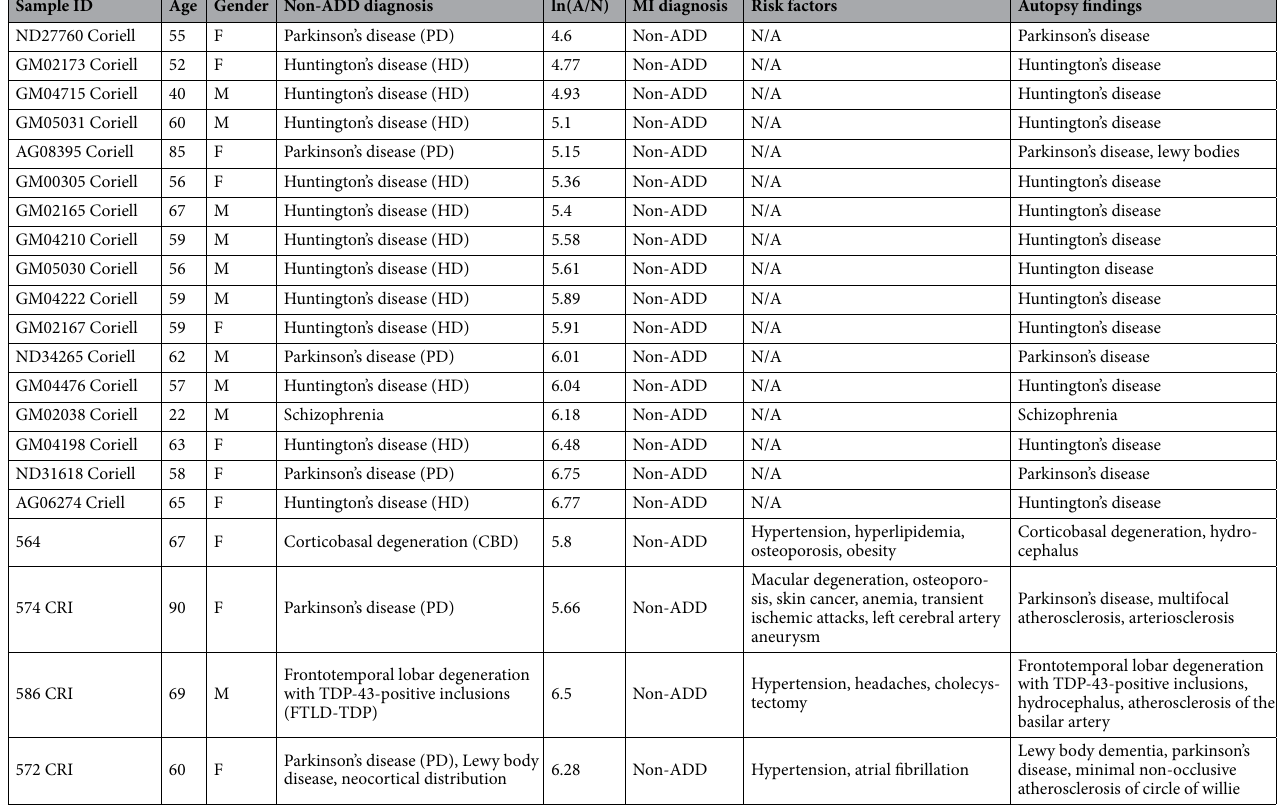
Table 2. Autopsy/genetically validated skin fibroblasts-based peripheral diagnosis of non-Alzheimer’s disease dementia (N =